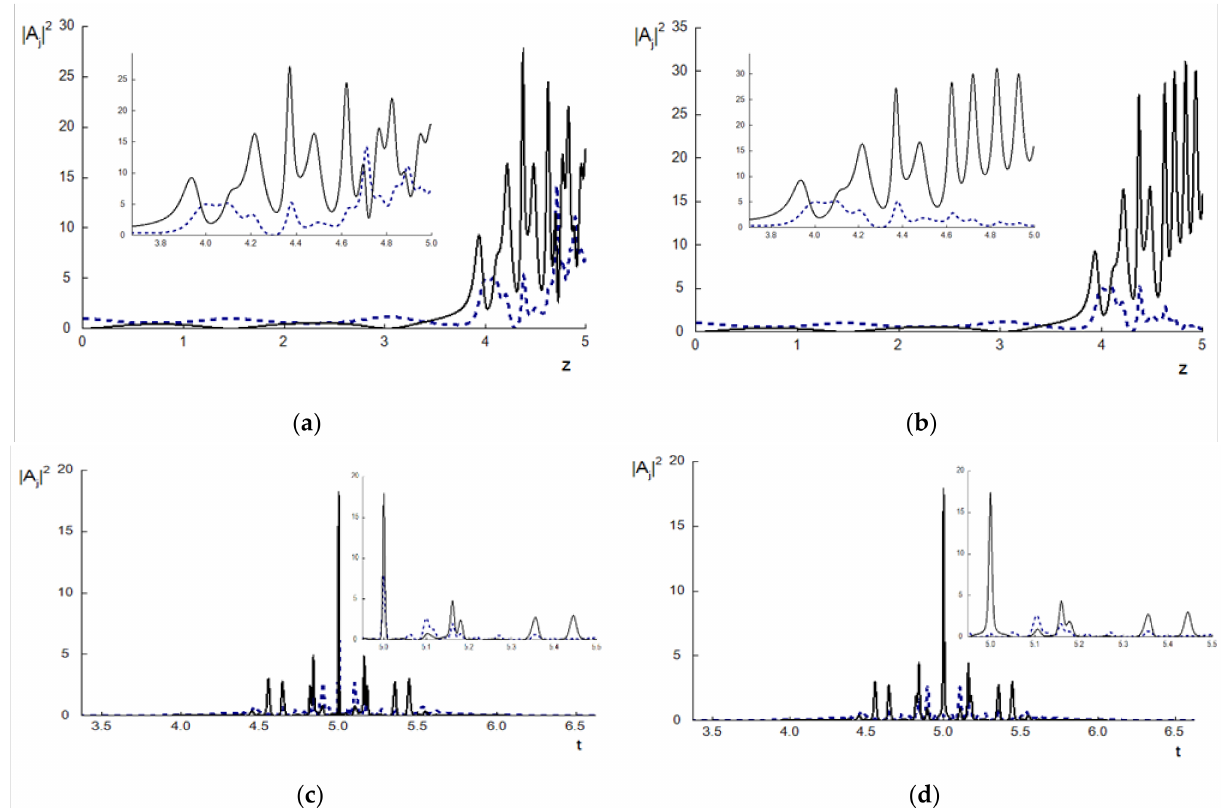
Figure 2. The intensity evolution at the pulse center ( t = 0.5 L t ) of the BW (dashed line) and TH (solid line) wave ( a , b ) and their pulse shapes in section z = 5 ( c , d ) computed using the CFDS-I3 ( a , c ) and CFDS-I1 ( b , d